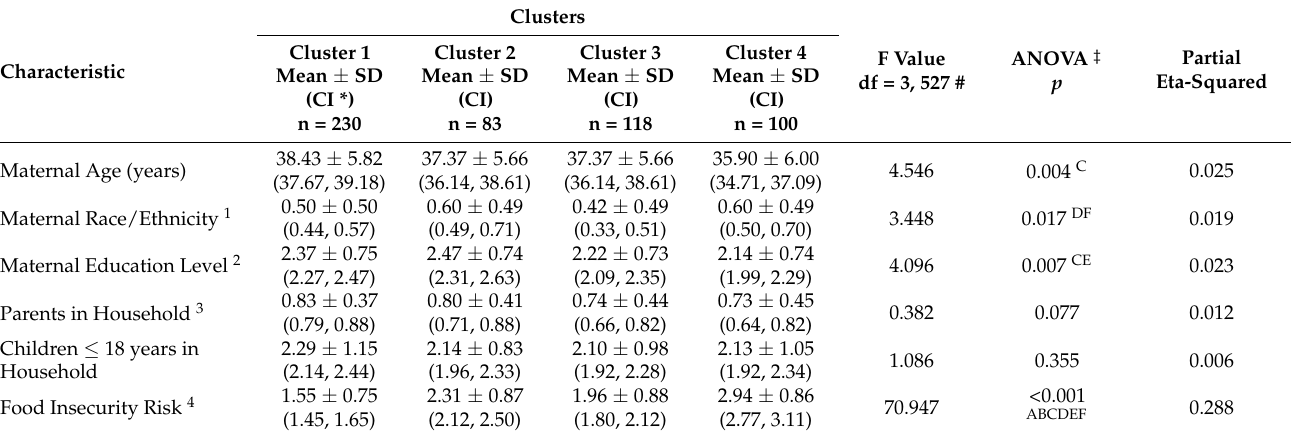
Table 2. Sociodemographic Characteristics by Maternal Mental Health Status Cluster (N =